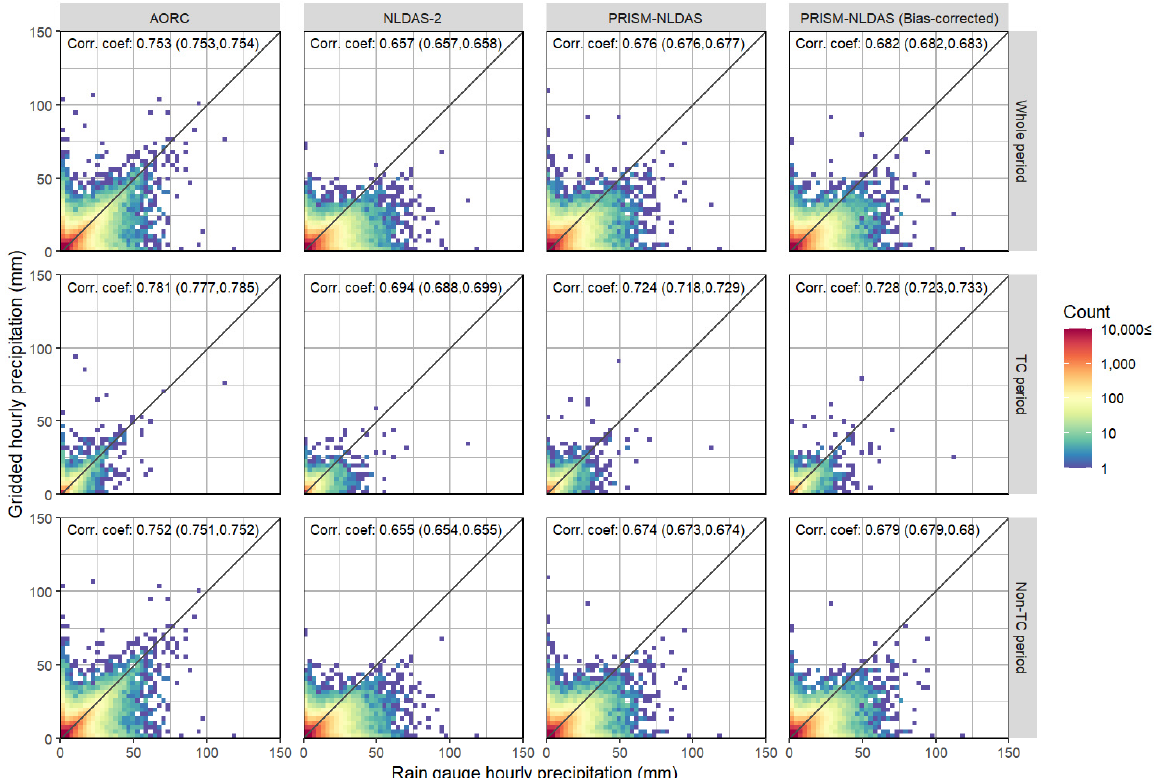
Figure 2. Plots showing the 2D histogram of rain-gauge and gridded hourly precipitation for the whole, TC, and non-TC periods. The values in parentheses are 95% confidence intervals for correlation coefficients.